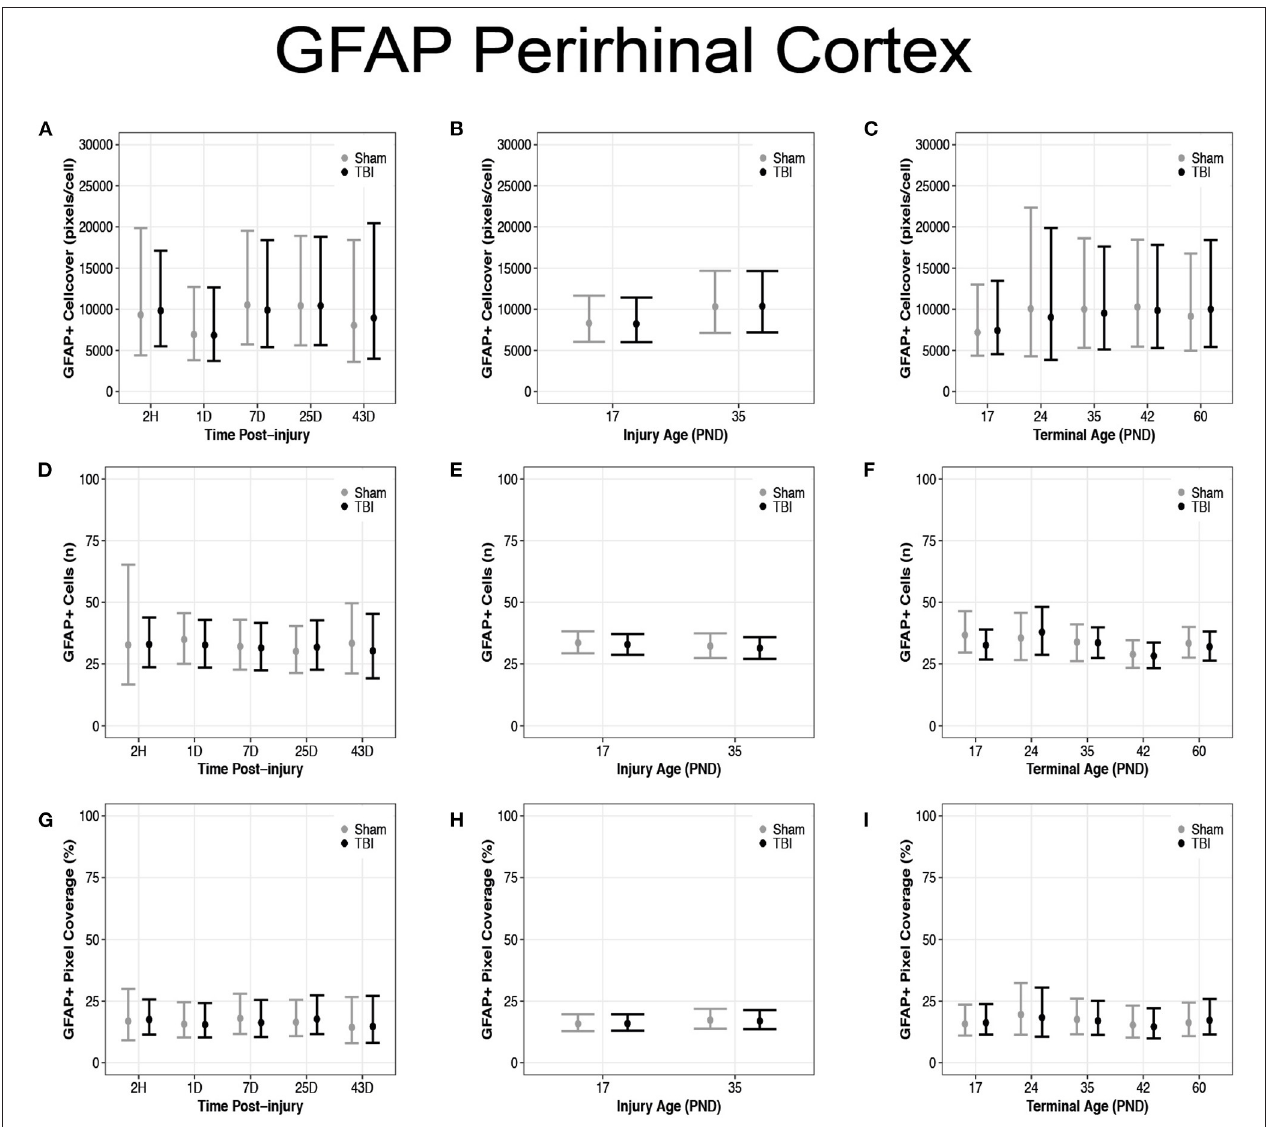
FIGURE 9 | Diffuse TBI did not affect GFAP expression in the perirhinal cortex. Point estimates (posterior means) and corresponding 95% credible intervals (highest posterior density intervals) are presented. There were no differences between sham and TBI rats across time post-injury, injury ages, or terminal ages (A–C) in cell coverage, (D–F) GFAP + cell number, (G–I) or pixel coverage